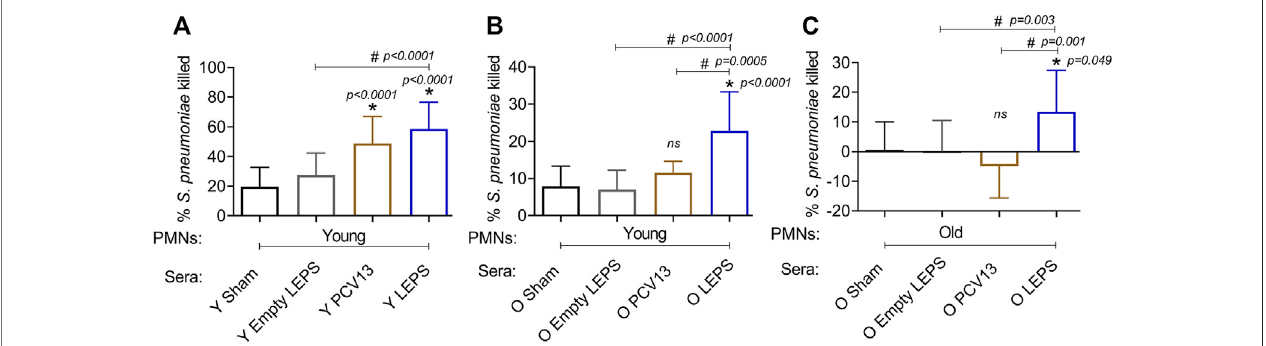
FIGURE 5| LEPS vaccination ofold mice induces sera with better opsonic activity compared to Prevnar-13 vaccination. Serawerecollected from young(Y) or old (O)miceimmunizedwithLEPScontainingserotype4capsularpolysaccharideantigen,PCV13,orthecontrols(ShamorEmptyLEPSvector)at4 weekspostvaccination following the timeline indicated in Figure 1B . The ability of sera to induce opsonophagocytic killing of bacteria by PMNs was determined. PMNs were isolated from the bone marrowofnaïveyoung(2 months) (A,B) orold (18 – 22 months) (C) C57BL/6 mice and mixed for45 min at 37 ° Cwith S.pneumoniae serotype 4TIGR4 strain pre-opsonizedwith3%serafromtheindicatedgroups.Reactionswerestoppedonice,andviableCFUweredeterminedafterserialdilutionandplating.Thepercentage ofbacteriakilledwasdeterminedwithrespecttoanoPMNcontrolforeachcondition.Asterisks(*)indicatesigni fi cantdifferenceswithrespecttotheShamgroup(ns:not signi fi cant) and hash signs (#) indicate signi fi cant differences between the indicated groups as calculated by one-way ANOVA followed by Tukey ’ s test. Data shown are pooled from three separate experiments ( n (cid:2) 3 biological replicates or mice per group) where each condition was tested in triplicate ( n (cid:2) 3 technical replicates) per experiment and presented as mean ±